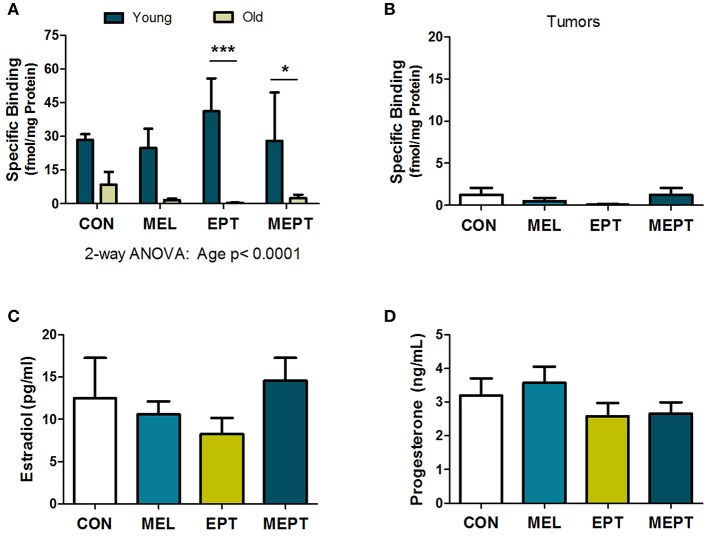
Melatonin binding sites in mammary tissues and tumors and serum estradiol and progesterone levels are not modified by the treatments. (A) Mammary tissues from 3-month-old mice in estrus (Young) and from aged mice (Old) in various stages of the estrous cycle (mean age ranges between 9.6 and 10.1 months) were examined for 2-[125I]-iodomelatonin binding. Significantly higher melatonin binding was detected in the young mammary glands (n = 3) compared to the old mice (n = 9) by two-way ANOVA (p < 0.0001), but treatment effects and their interaction were not significant. Significantly lower melatonin binding was detected in the old EPT vs. young EPT mice (***p < 0.001) and old MEPT vs. young MEPT mammary glands (*p < 0.05) by the Bonferroni post-test. (B) Like mammary tissue from aged mice, mammary tumors (age means range between 10.8 and 11.5 months, n = 9) had meager melatonin binding (note the lower range on the y-axis compared to A). No significant differences were detected by one-way ANOVA and Dunnett's multiple comparison post-test. (C) The treatments did not significantly modify serum estradiol levels (pg/mL) and (D) serum progesterone levels (ng/mL) from 3-month-old Neu females in estrus by one-way ANOVA. Mean ± SEM are shown.